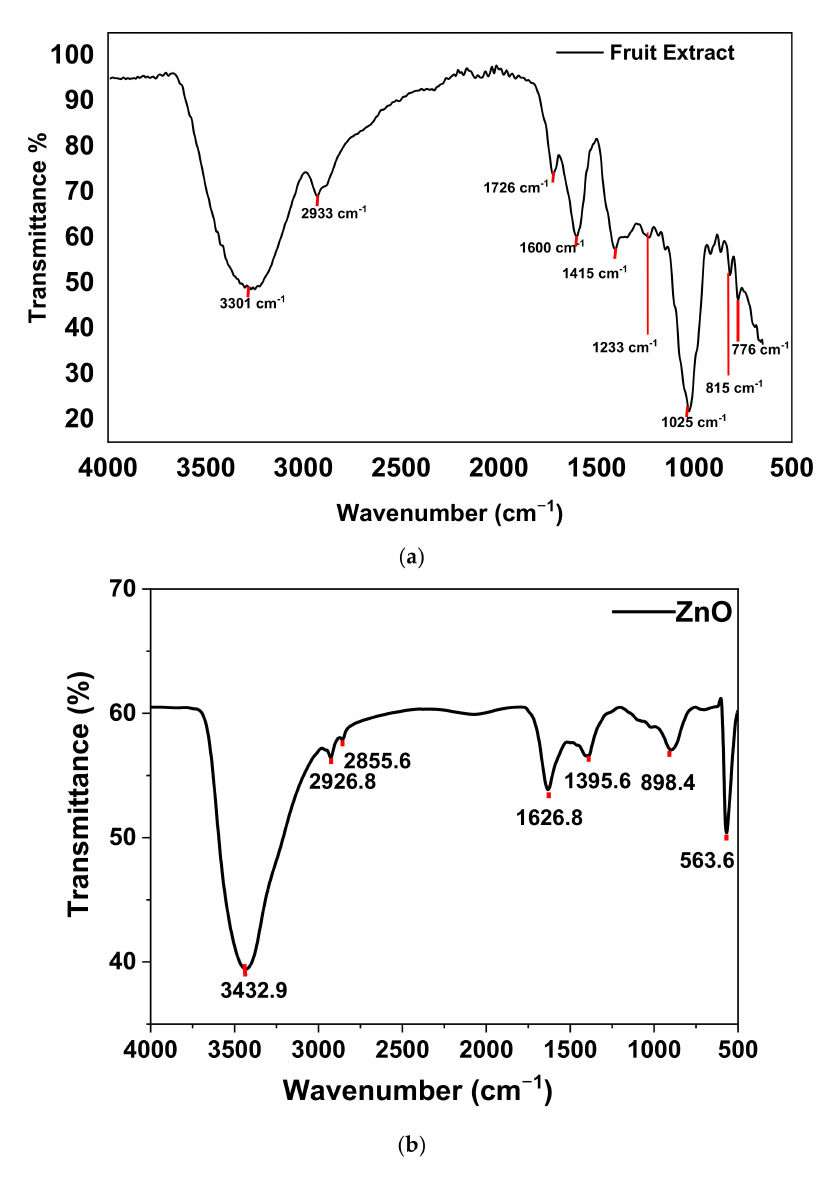
Figure 7. FTIR of ( a ) fruit extract and ( b )